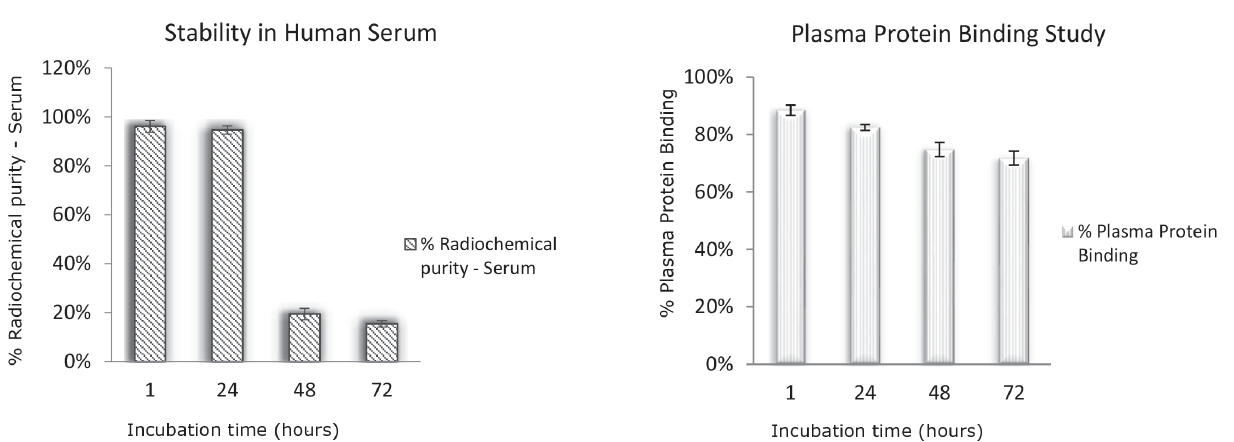
FIGURE 8 - Radioimmunoconjugate stability in human serum (A); % protein binding (B). Results expressed as mean ± SEM (n>